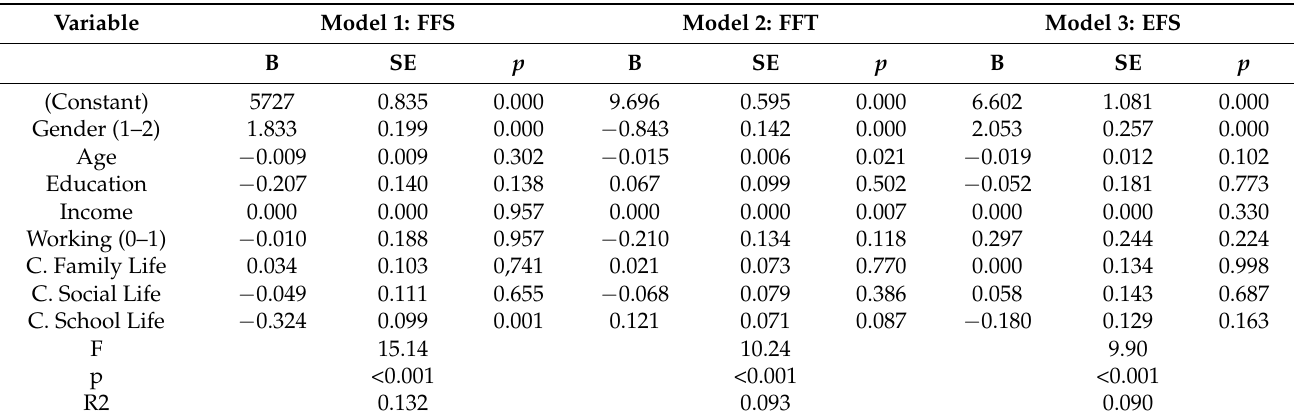
Table 2. Main Regression Effects on Gender Role Attitudes Scale’s Factors.